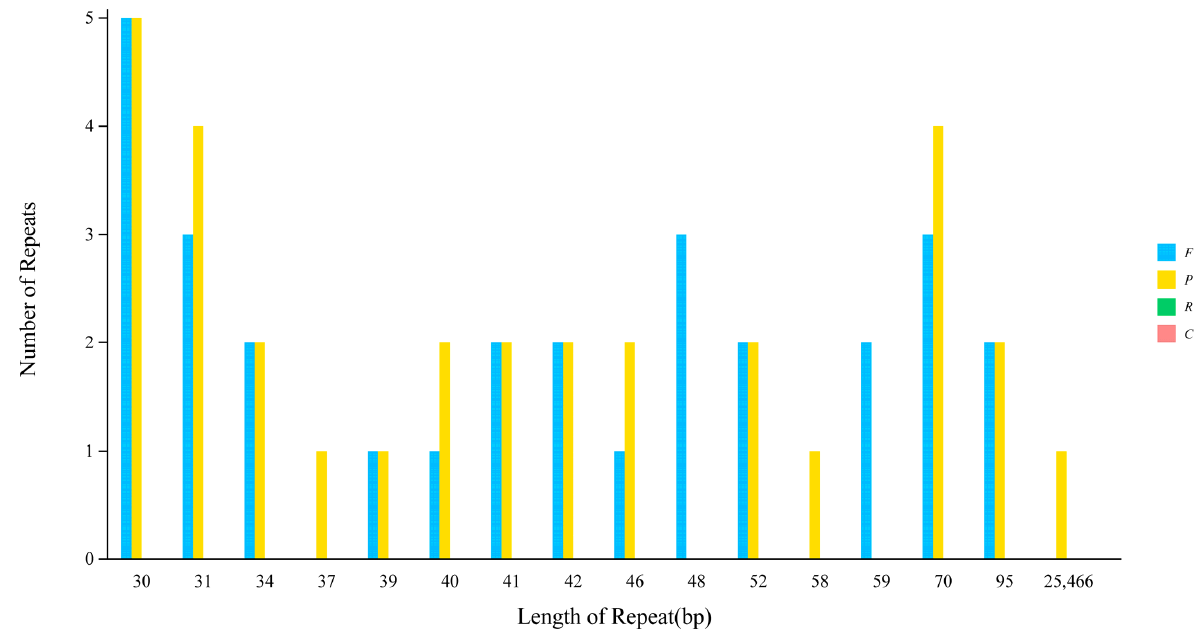
Figure 3. Representation of types and number of repeat sequences in the chloroplast genome of wild pomegranate. The abbreviation stands for ‘F’ forward repetition, ‘P’ palindromic repetition, ‘R’ reverse repetition, and ‘C’ for complementary repetition. Different color indicates the individual repeats.